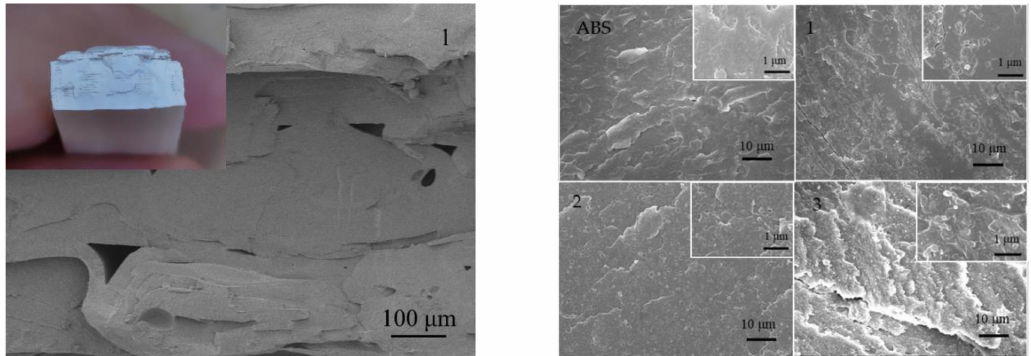
Figure 7. Cross-section morphology of ABS / octyl-QDED without magnification ( upper left ), at low magnification ( left ), and at high magnification ( right